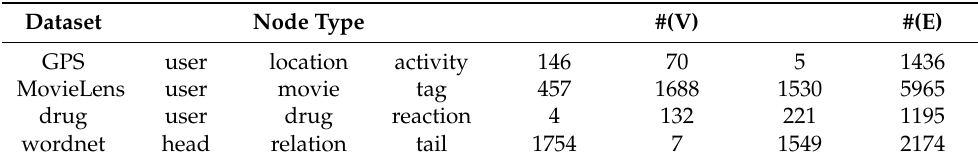
Table 2. Dataset